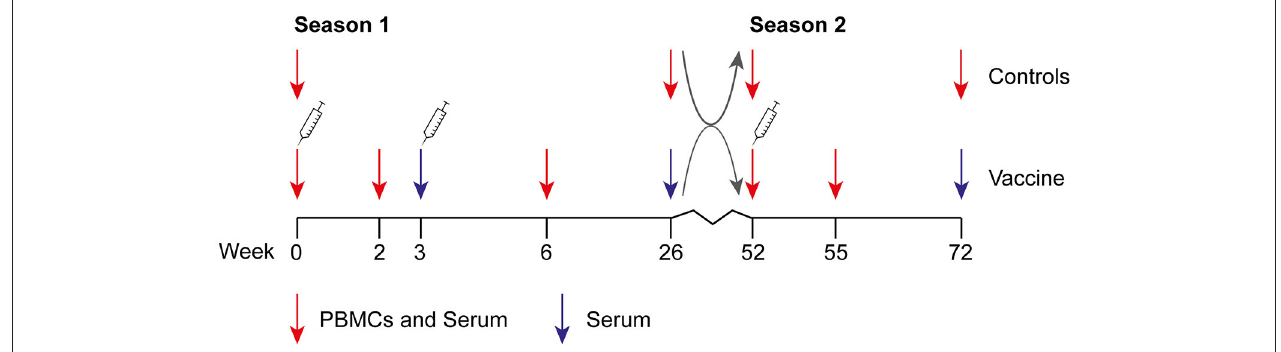
FIGURE 1 | Design of the clinical study. The study was performed during two consecutive influenza seasons. During season 1 (2009–2010), individuals were vaccinated at the start of the study and 3 weeks later with the MF59-adjuvanted subunit vaccine. Three weeks before the start of the study or at week 6, an optional seasonal 2009–2010 vaccination was allowed. Gray arrows depict reallocation in control and vaccine groups. During season 2 (2010–2011), individuals in the vaccine group received the unadjuvanted seasonal 2010–2011 subunit vaccine at week 52. An unvaccinated control group was included in both seasons. Study participants could change between vaccine and control group at the start of season 2, resulting in a vaccine (V 1 ) and control (C 1 ) group in season 1 and vaccine-vaccine (V 1 V 2 ), vaccine-control (V 1 C 2 ), control-control (C 1 C 2 ), and control-vaccine (C 1 V 2 ) groups in season